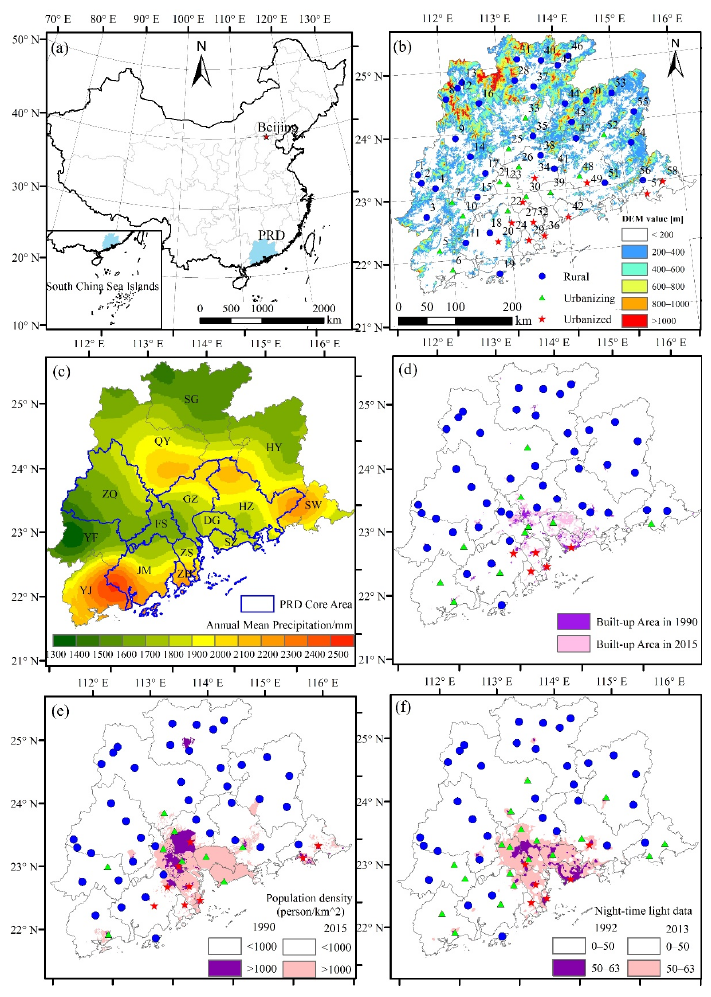
Figure 1. ( a ) Location of the PRD metropolitan area in China; ( b ) the spatial distribution of meteor- ological stations used in this study (the number listed in Table S1); ( c ) the spatial distribution of annual mean precipitation in the PRD during 1961–2017; ( d – f ) the results of rural, urbanizing and urbanized stations from the land-use, population, and night-time light data, respectively.